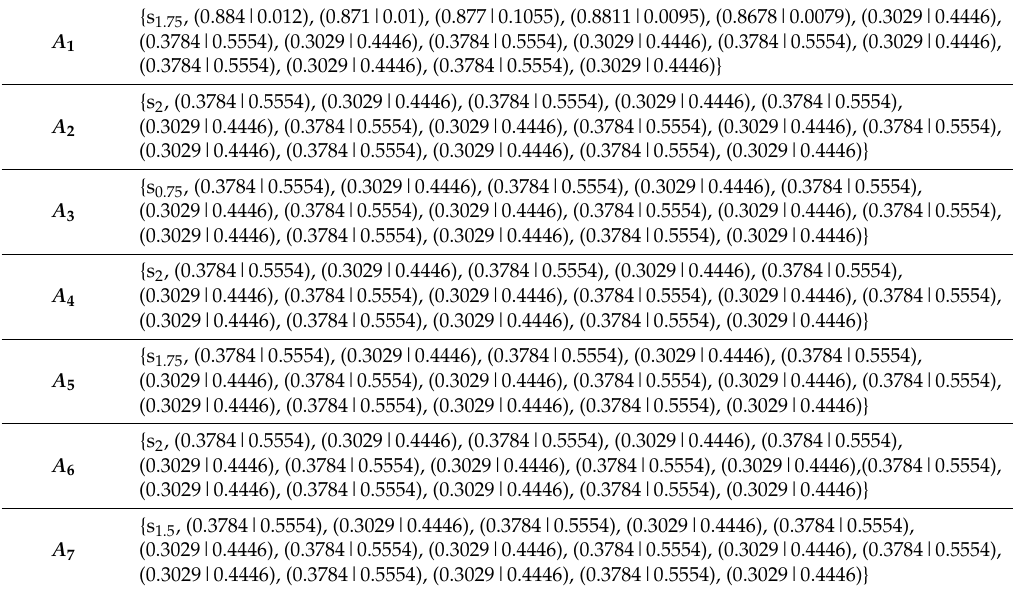
Table 14. Collective hesitant probabilistic fuzzy linguistic decision matrix